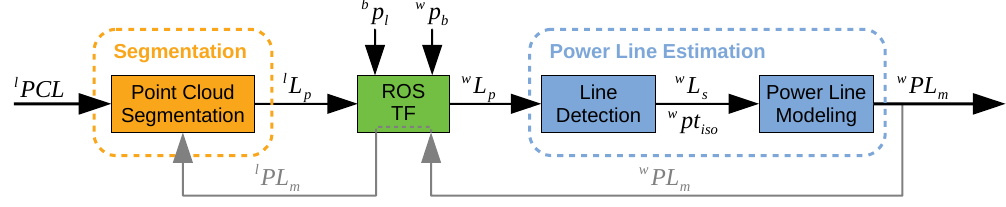
Figure 3. Concept of the proposed algorithm